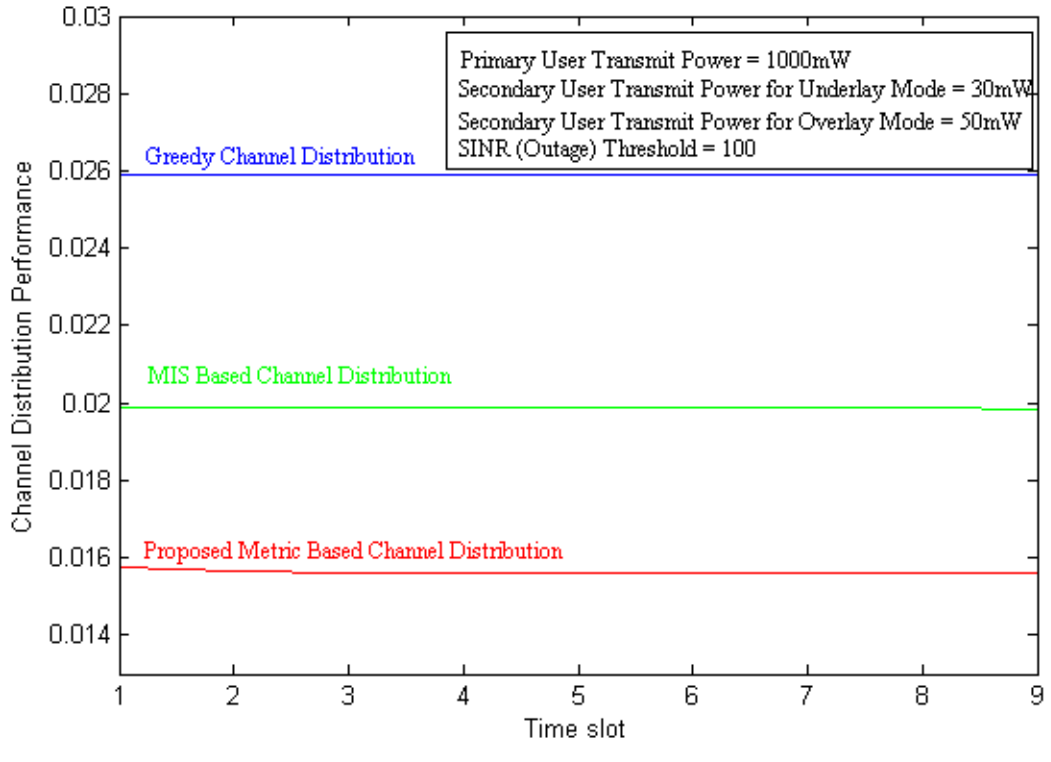
Figure 14. ChDistFairness against time slots for 3 algorithms when the SINR (outage) threshold is 100.